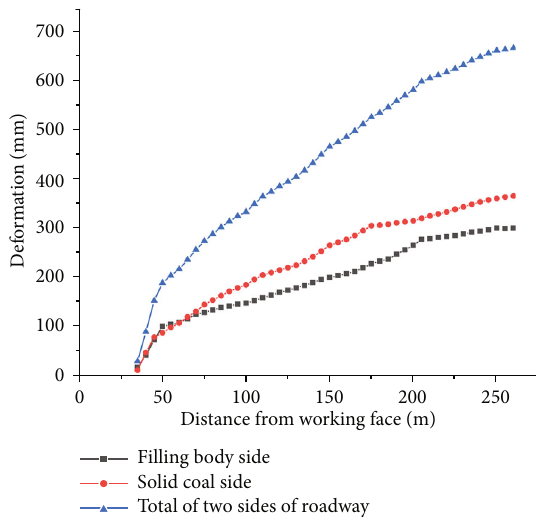
Figure 12: Relationship curve between deformation of fi lling body and distance from working face in 24207 gob-side entry